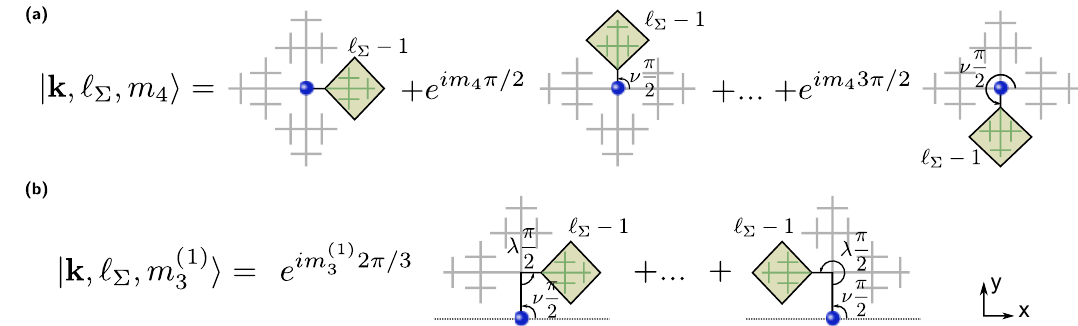
Figure 3: The rotational basis consists of superpositions of string states on the Bethe lattice, defined around a rotational center. There is (a) one m quantum number 4 around the central site, and (b) one m quantum number per every node except the 3 center. Angles νπ/ 2 are measured relative to the x -axis and λπ/ 2 relative to the preceding string segment. Note that in (b) only one branch of the Bethe lattice, with fixed ν , is